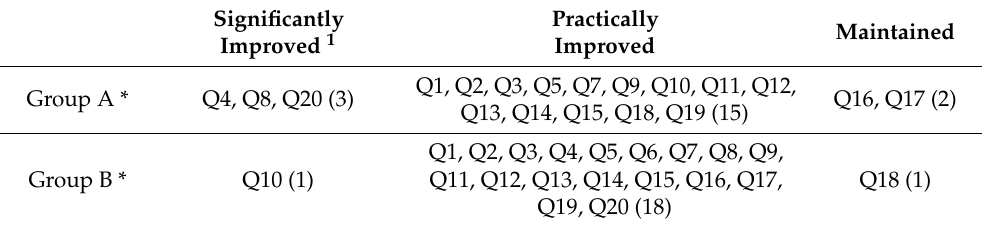
Table 6. Comparison of decrease in time for each question after applying VCDA.